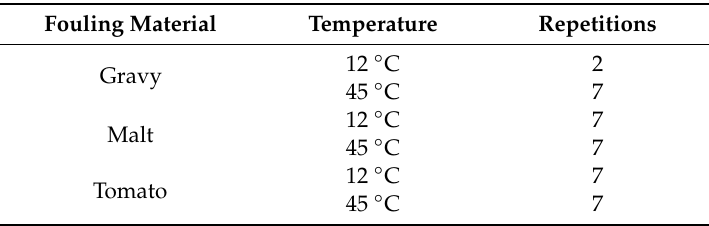
Table 1. Experimental